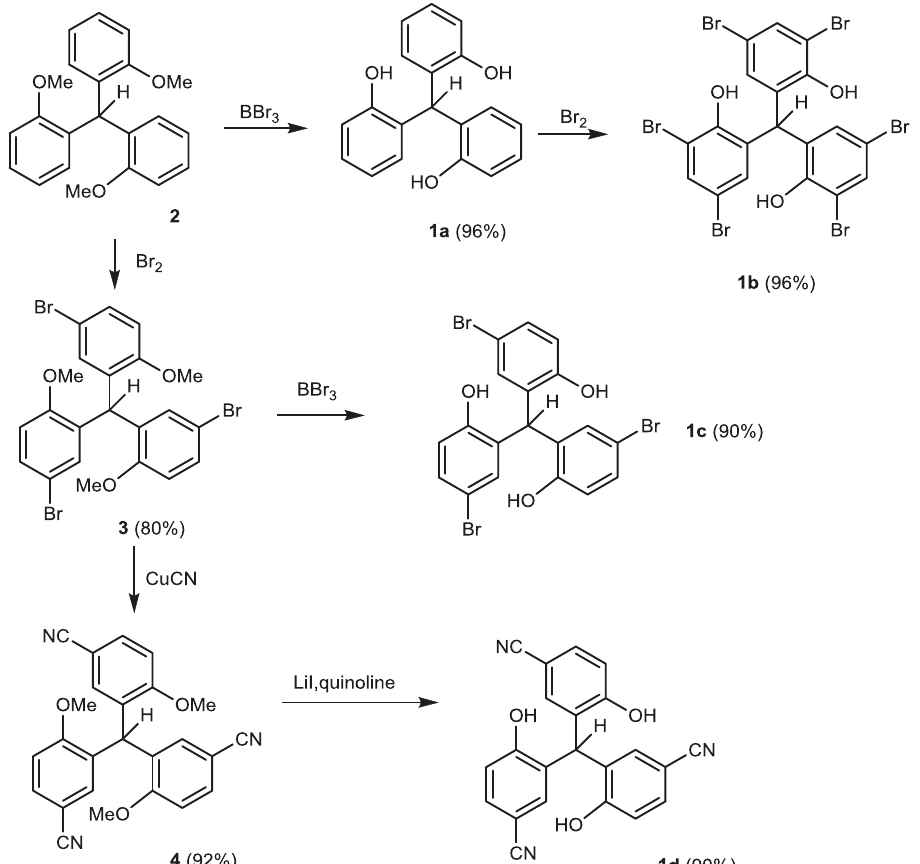
Fig. 2 Synthesis of the multidentate ligands 1a – d. The ligands 1a – d were synthesized from the same staring material ( 2 ) in gram-scale within three steps.